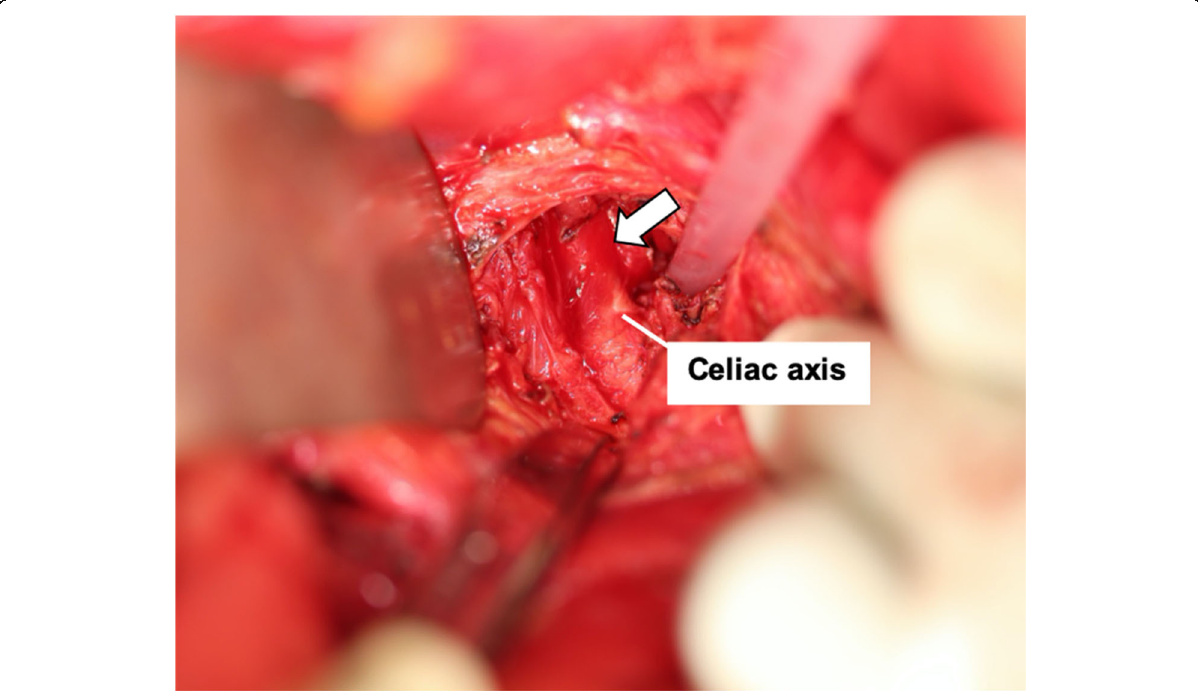
Fig. 5 The intraoperative identification of the median arcuate ligament (shown by